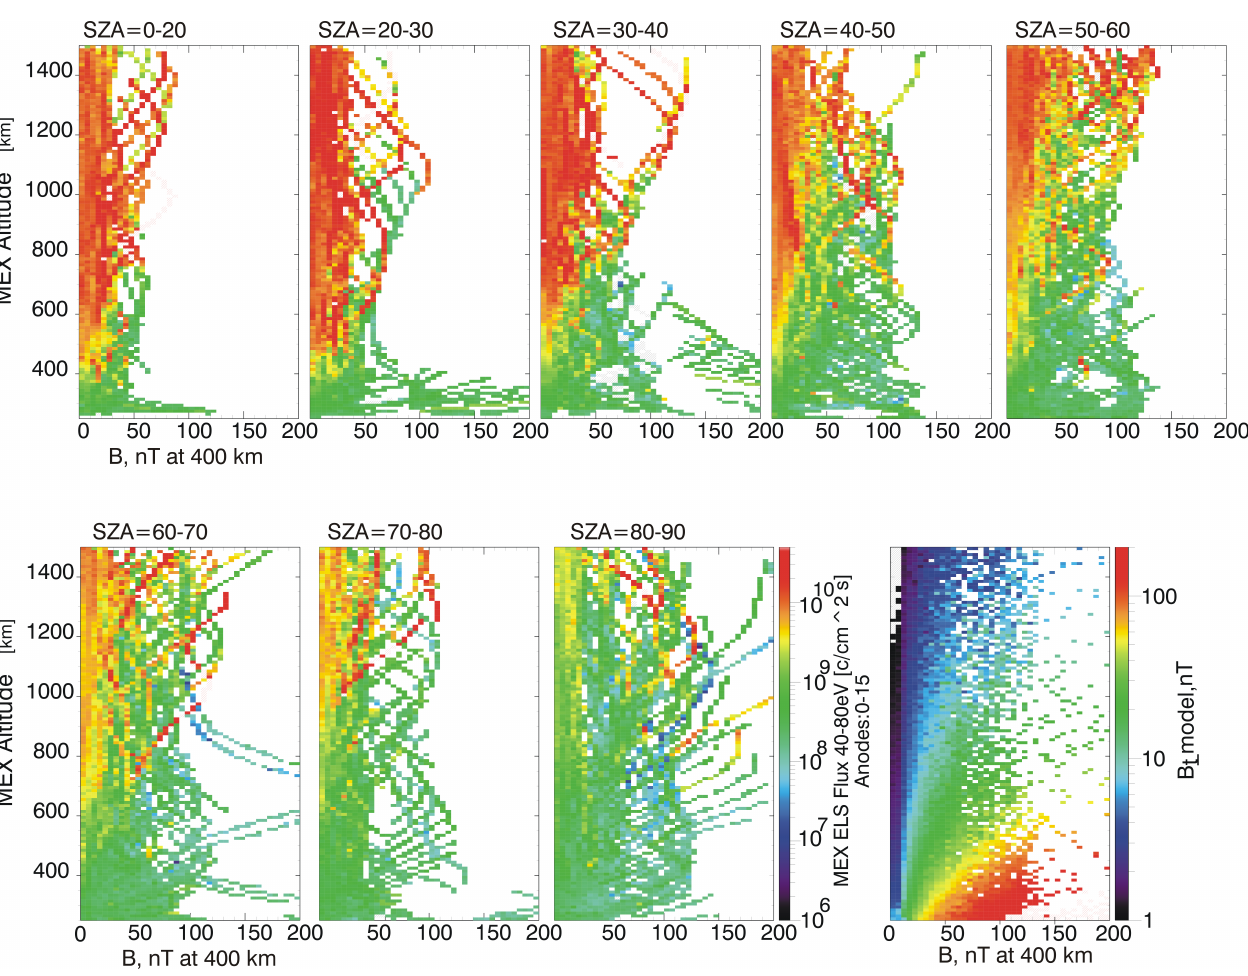
Fig. 3. Maps of electron access as a function of the strength of the crustal field B cr at the altitude of 400km and altitude ( h ) of the spacecraft for different solar zenith angles. (right panel) crustal magnetic field strength inferred from the model by Cain et al.